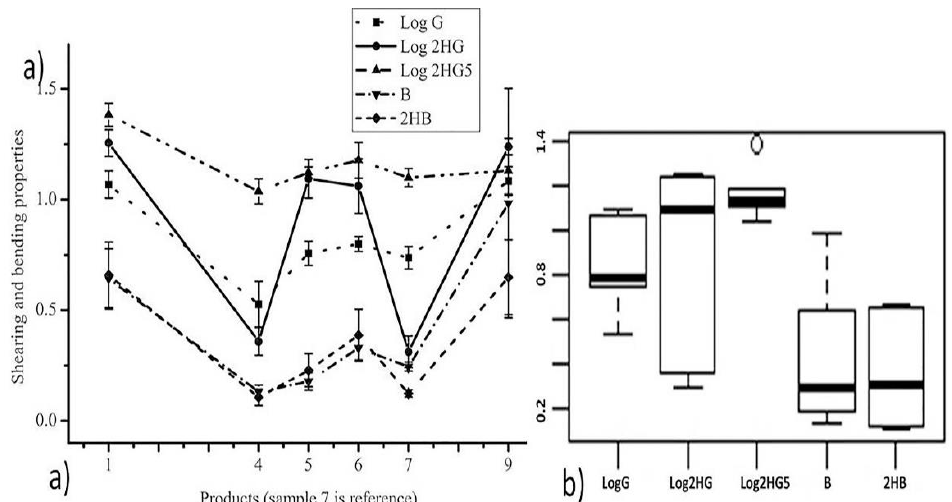
Figure 5. ( a ) The shearing and bending properties results under various finishing methods and ( b ) the box plot showing the variability of the bending and shearing properties within the samples. Some parameters are drawn using logarithmic values for the scaling purpose only. The change in shear hysteresis 2HG for different functional treatment is high when compared to the control sample except in conductive inkjet-printed (4) samples.